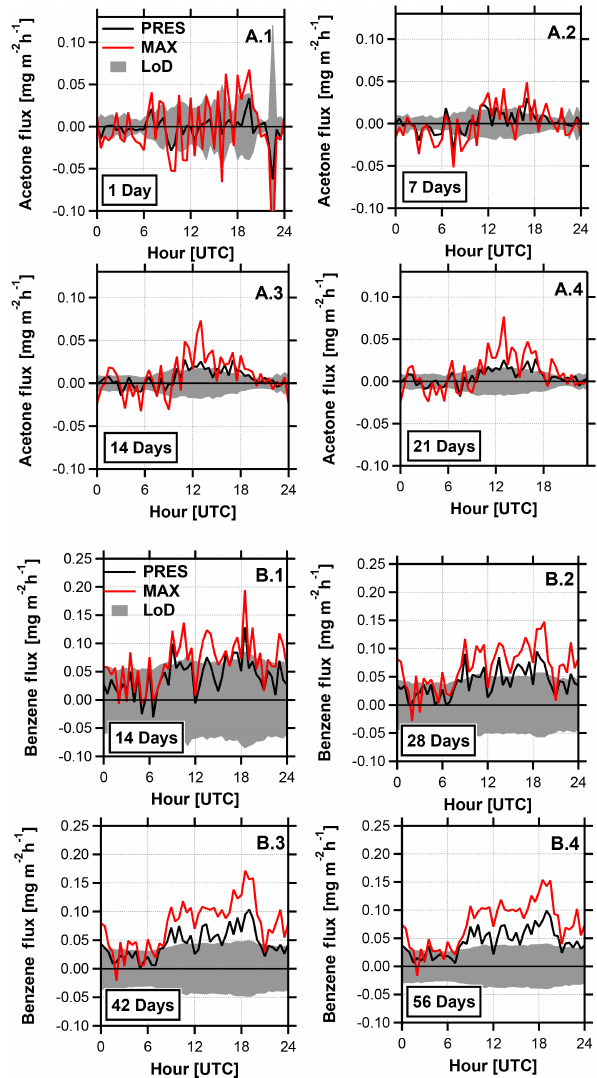
Figure 10. (a) Averaged diurnal profiles of acetone flux data ob- tained using a quadrupole PTR-MS. Increasing the number of av- eraged data points does not bring the PRES flux above the LoD (greyed area indicates the LoD at the 95th percentile), indicating no detectable flux. By contrast, the MAX fluxes, which are highly bi- ased, show some periods above the LoD which are an artefact of the MAX time-lag determination method. (b) Averaged diurnal profiles of benzene flux data obtained using a quadrupole PTR-MS. Increas- ing the number of data points averaged from 14 to 56 is sufficient to distinguish the flux calculated with a prescribed time lag from the LoD (greyed area indicates the LoD at the 95th percentile) and indicates a clear flux of